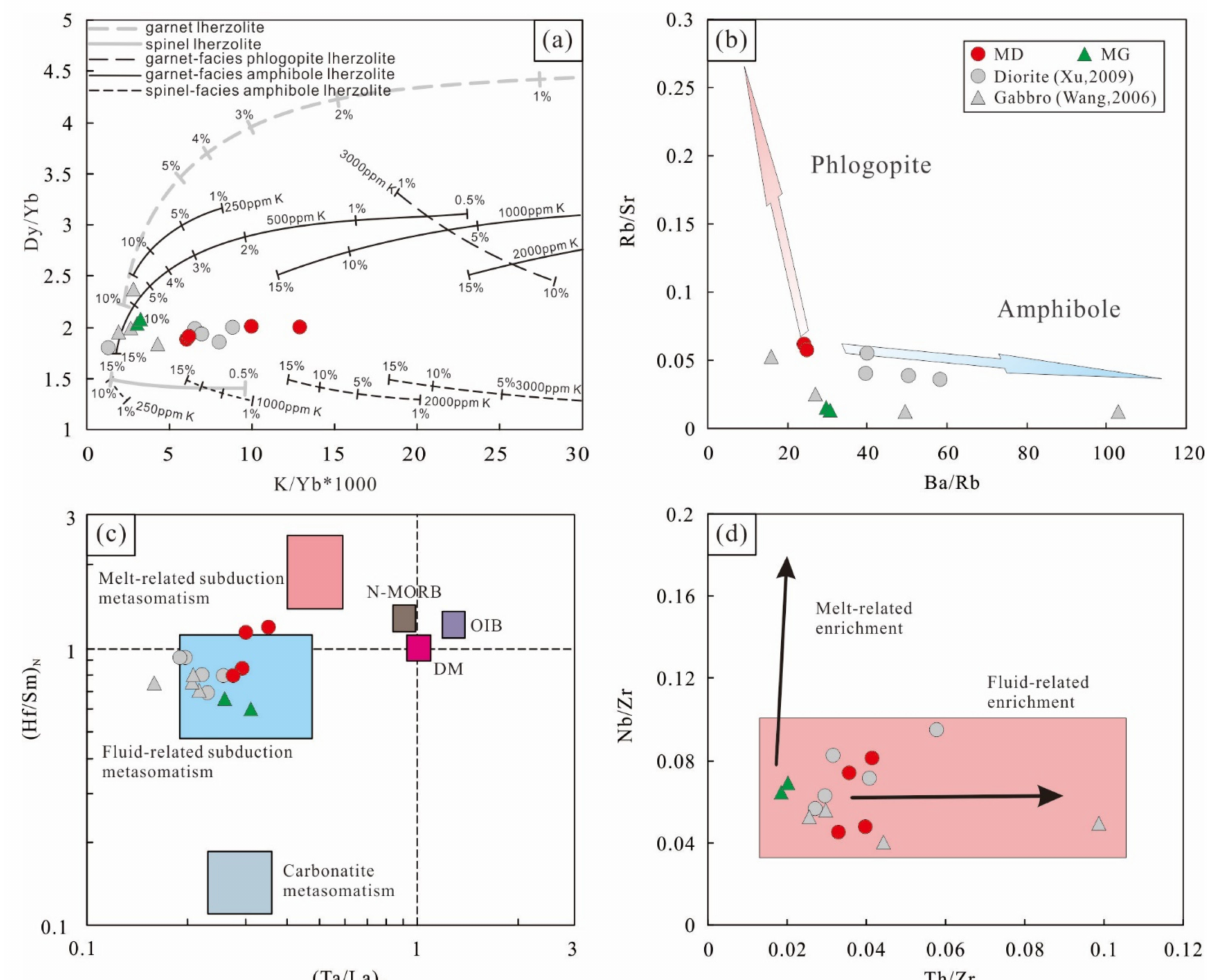
Figure 14. ( a ) The K/Yb versus Dy/Yb and ( b ) the Rb/Sr versus Ba/Rb diagrams. Melting curves for garnet lherzolite, spinel lherzolite, garnet-facies phlogopite lherzolite, garnet-facies amphibole lherzolite and spinel-facies amphibole lherzolite are after [79]. ( c ) (Hf/Sm) N versus (Ta/La) N diagram [77]. ( d ) Nb/Zr versus Th/Zr